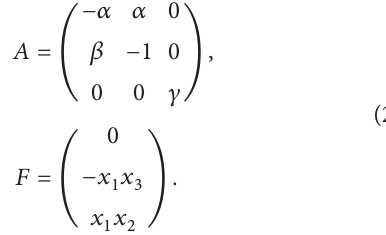
which has a chaotic attractor, for example, when (𝛼, 𝛽, 𝛾) = (10, 28, −8/3) [45]. Then the linear part 𝐴 = (𝑎 nonlinear part 𝐹 of the Lorenz system (24) are given